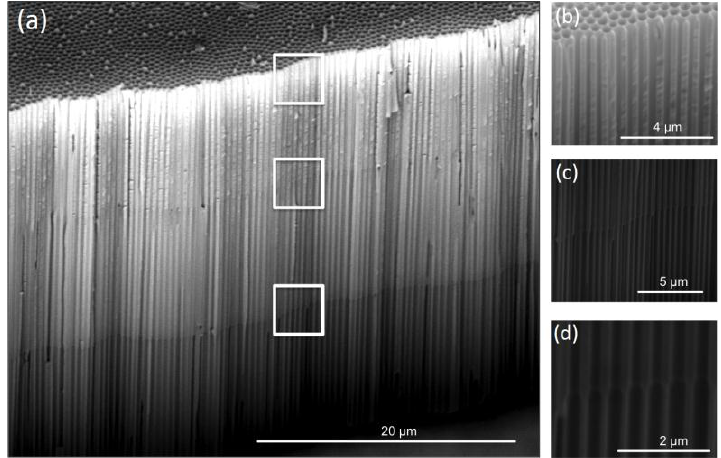
Figure 4. Cross section ESEM images of a three layered inverted funnel structure (IF3): ( a ) entire length of the inverted funnels, and ( b – d ) magnifications of the framed areas from top to bottom .